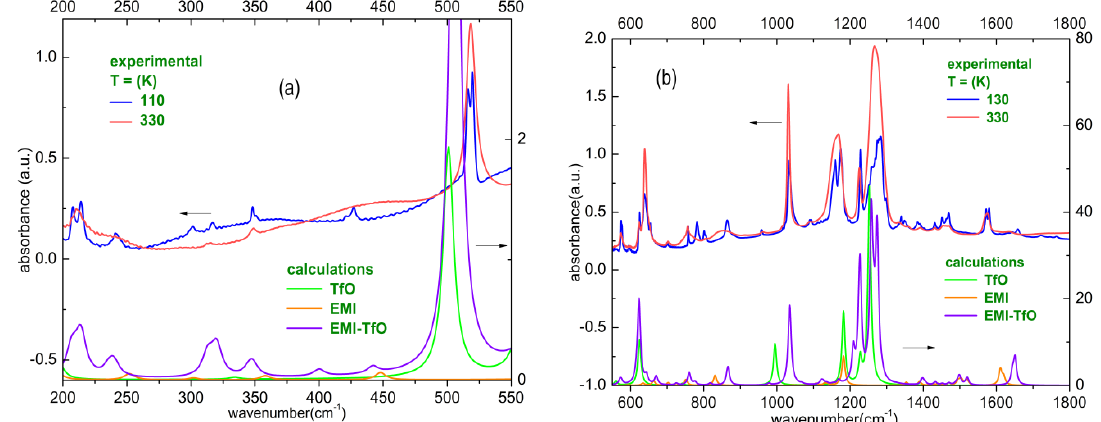
Figure 6. Comparison of the experimental absorbance spectra of EMI–TfO at 110 and 330 K (top part of the panels) with the calculations (bottom part of the panels). For the isolated TfO ion, a frequency scaling factor of 0.97 was used. The panel ( a , b ) reports the far- (mid-) infrared range.